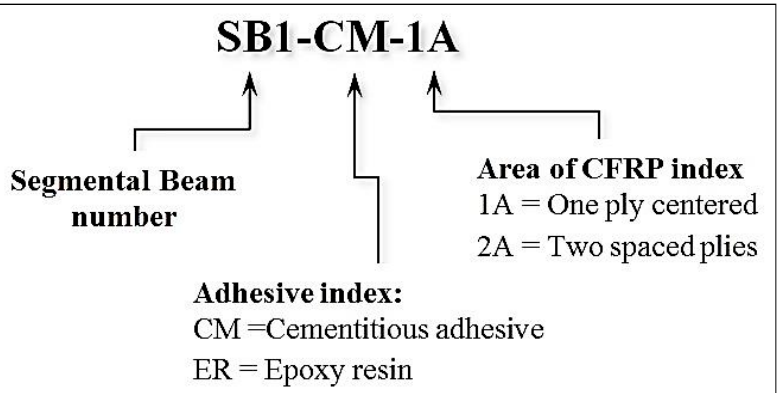
Figure 1. Specimen designation system.